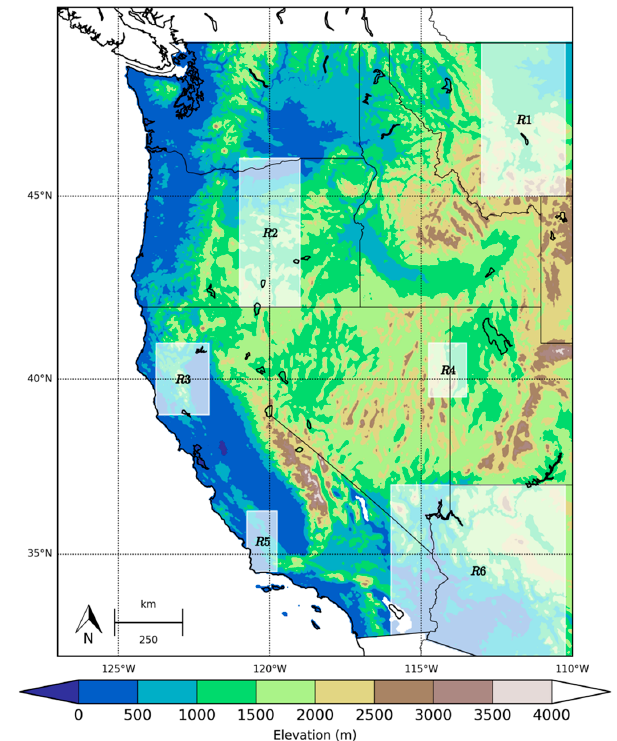
Figure 1. The study area and the terrain represented at a 0.44° resolution where the numbered boxes with white boundaries indicate the sub-regions in which the area-mean time series are evaluated. Region 1 ( R1 ) is western Montana, ( R2 ) is central Oregon, ( R3 ) is a portion of northern California, ( R4 ) is a northern Utah/Nevada, ( R5 ) is a small area near Los Angeles, and ( R6 ) is Arizona, and a portion of southern California and Nevada.